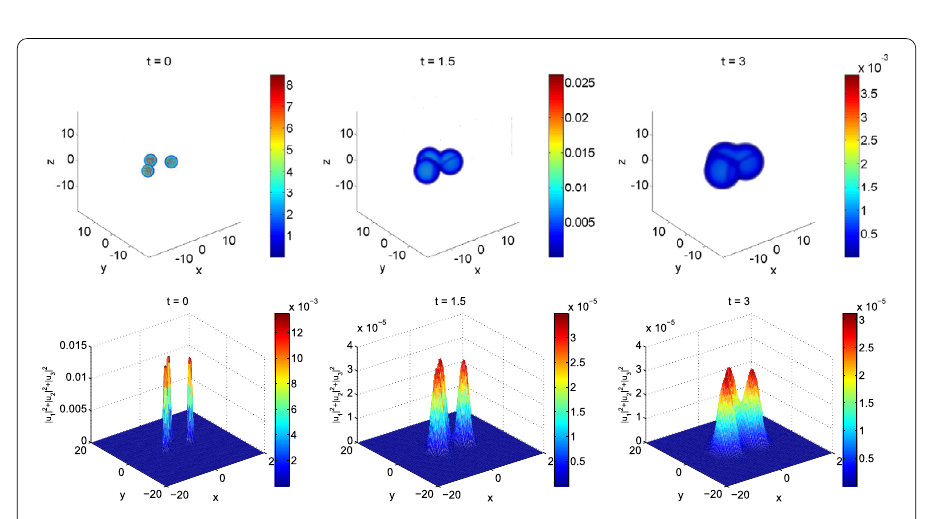
Figure 14 Profile of solutions to 3CNFSE (26) using the spectral ETDRK4-P13 scheme ( α = 1.5, N = 160)